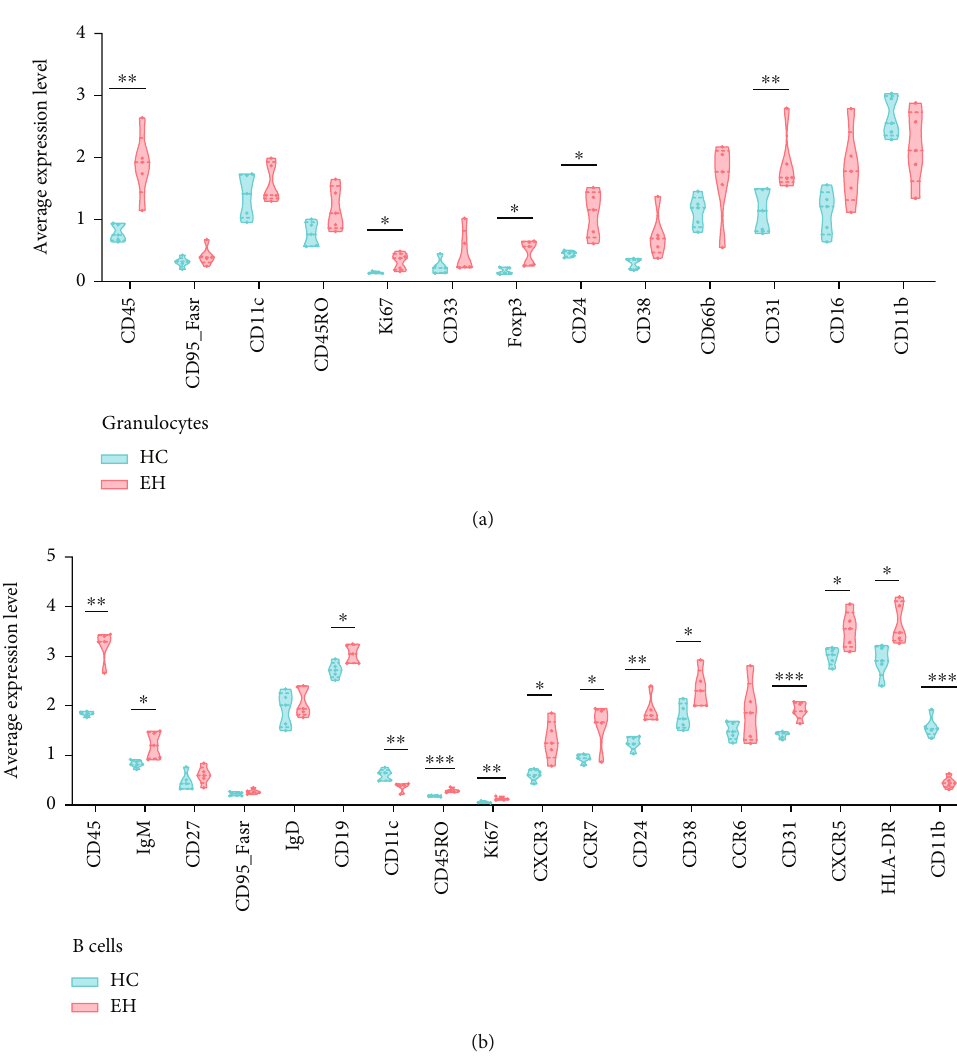
Figure 4: Di ff erence of granulocytes and B cells between the HC and EH groups. (a) The di ff erence in the average expression level of antigens in granulocytes of the HC and EH groups. (b) The di ff erence in the average expression level of antigens in B cells of the HC and EH groups. ∗ P < 0 : 05 , ∗∗ P < 0 : 01 , ∗∗∗ P < 0 : 001